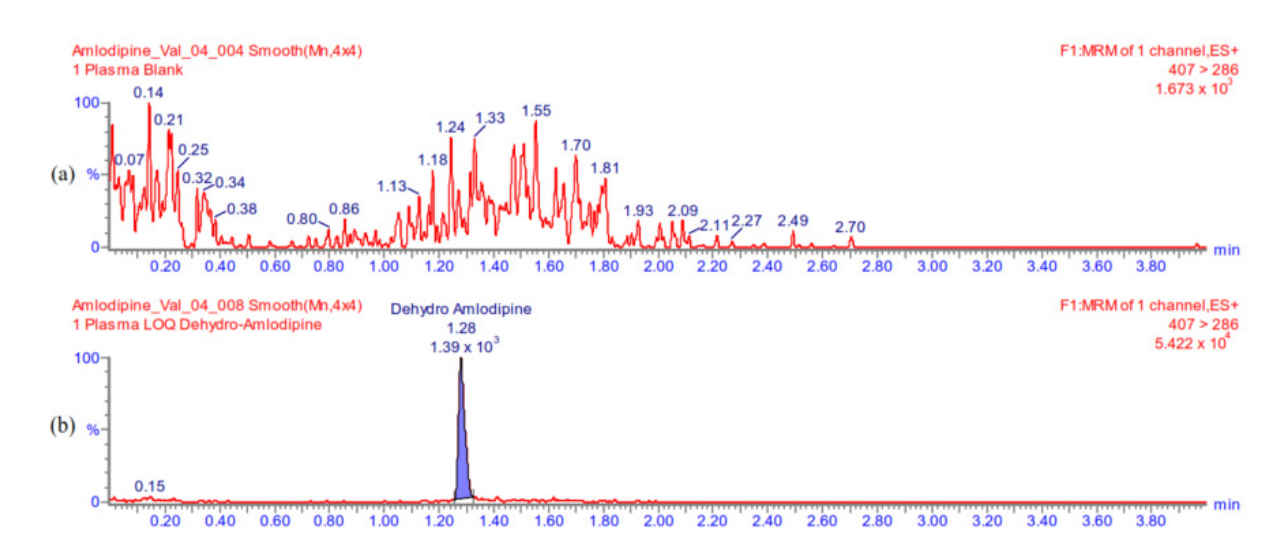
Figure A2. DAML MRM chromatograms of plasma source 1. ( a ) Blank plasma sample. ( b ) Plasma spiked with DAML at 1.0 ng/mL.